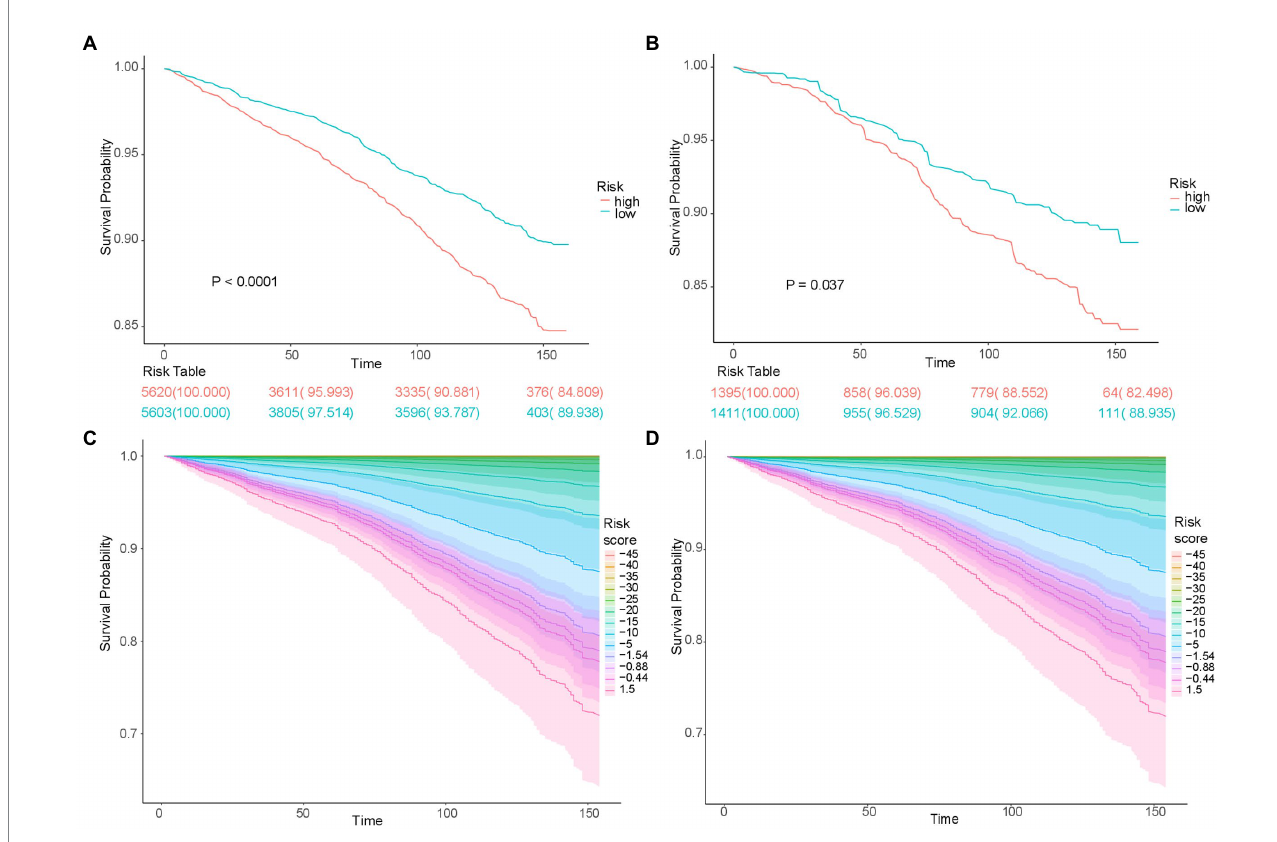
FIGURE 4 The survival time of patients according to the risk score. Kaplan–Meier analyses of survival time based on risk group in the training cohort (A) and testing cohort (B) . Kaplan–Meier analyses of survival time based on different risk score levels in the training cohort (C) and testing cohort (D)